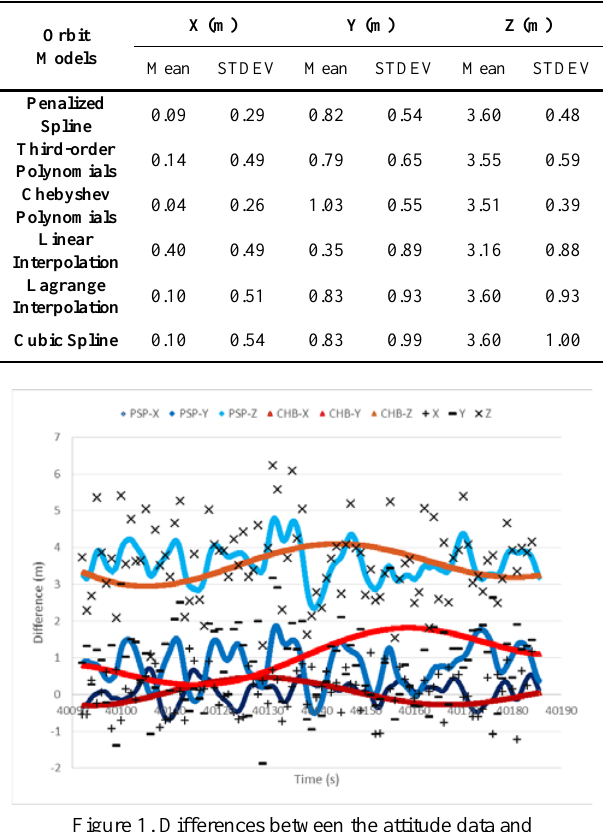
Table 1 Mean value and variance of the differences between the